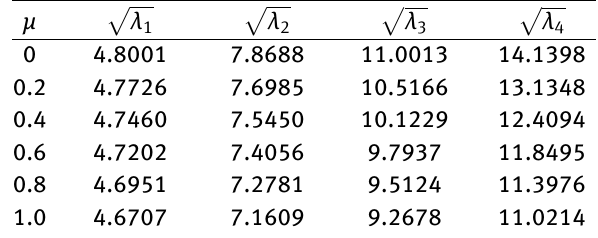
Table 12: Frequency parameter